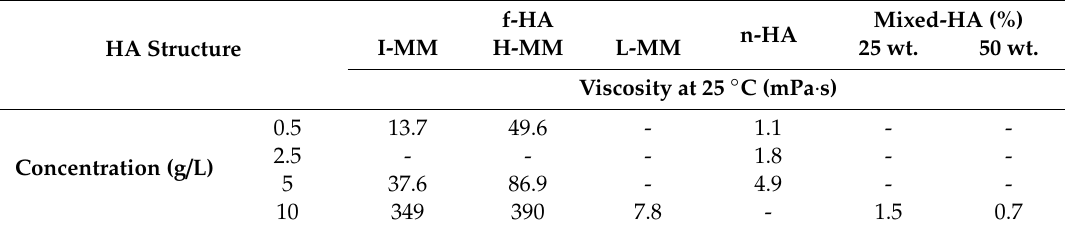
Table 2. Viscosities of HA formulations as a function of the concentration. (f-HAs) with high